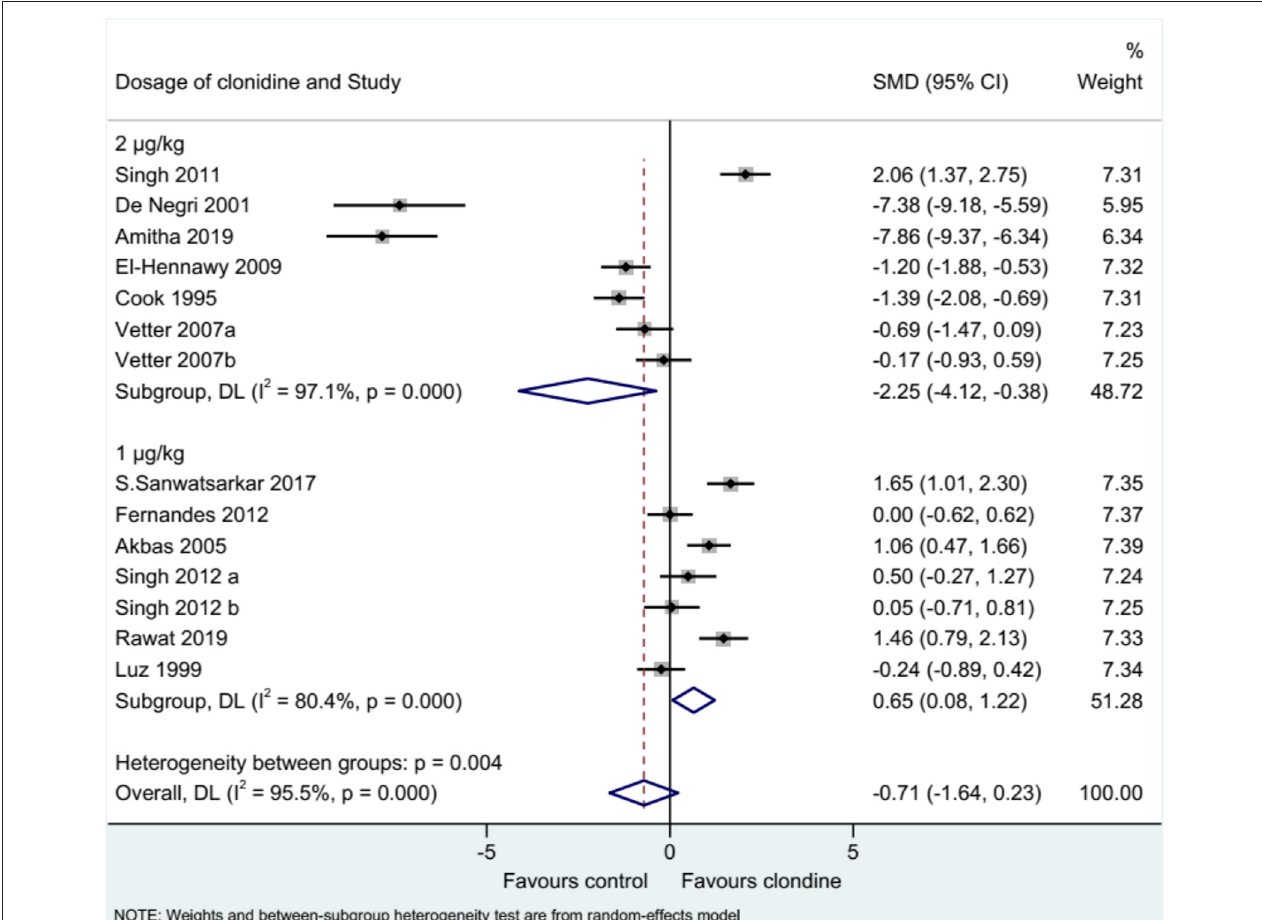
FIGURE 4 | Subgroup analysis of analgesia duration by the dosage of clonidine.